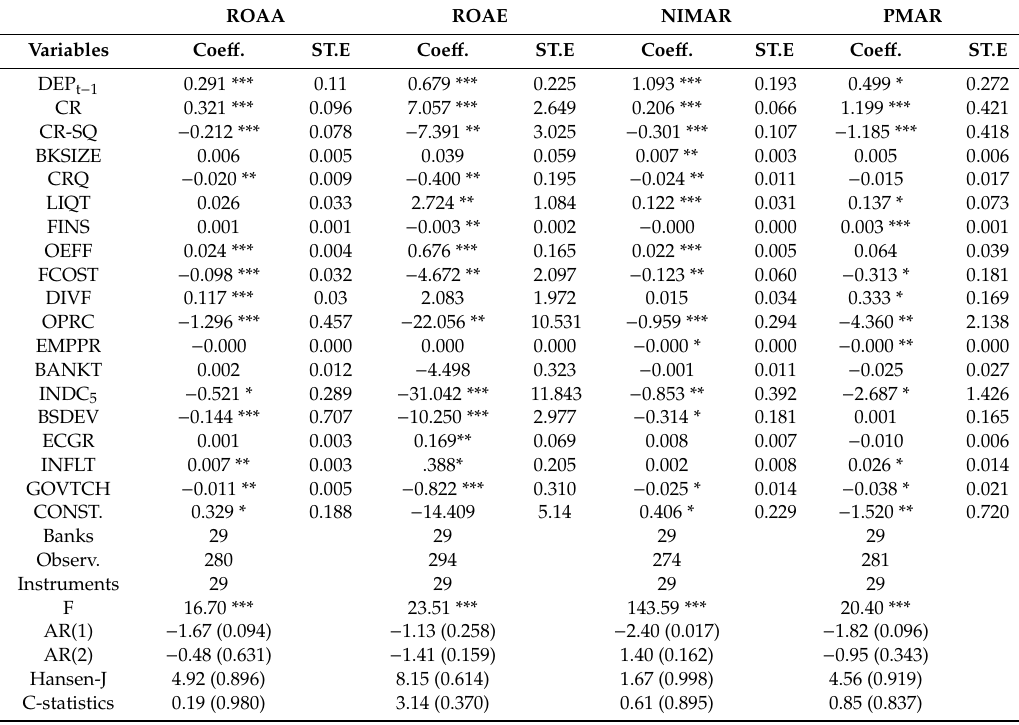
Table 7. Capital Ratio (CR) and